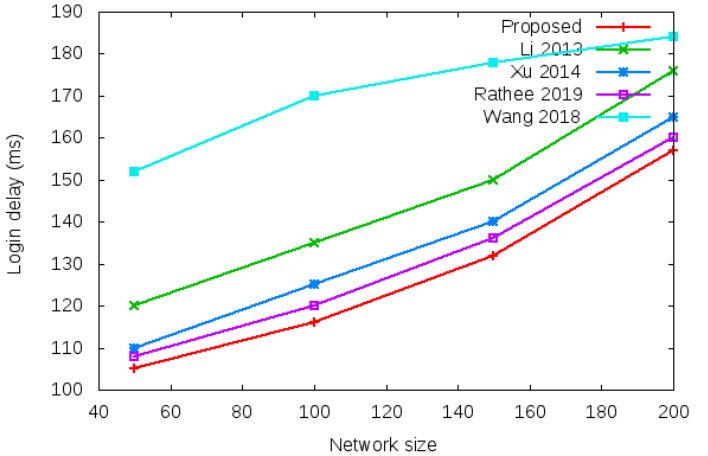
Figure 9. Login delay of the proposed protocol versus existing protocols with a different network size of 50, 100, 150, and 200 nodes based on total computational cost and total communication cost during the login authentication